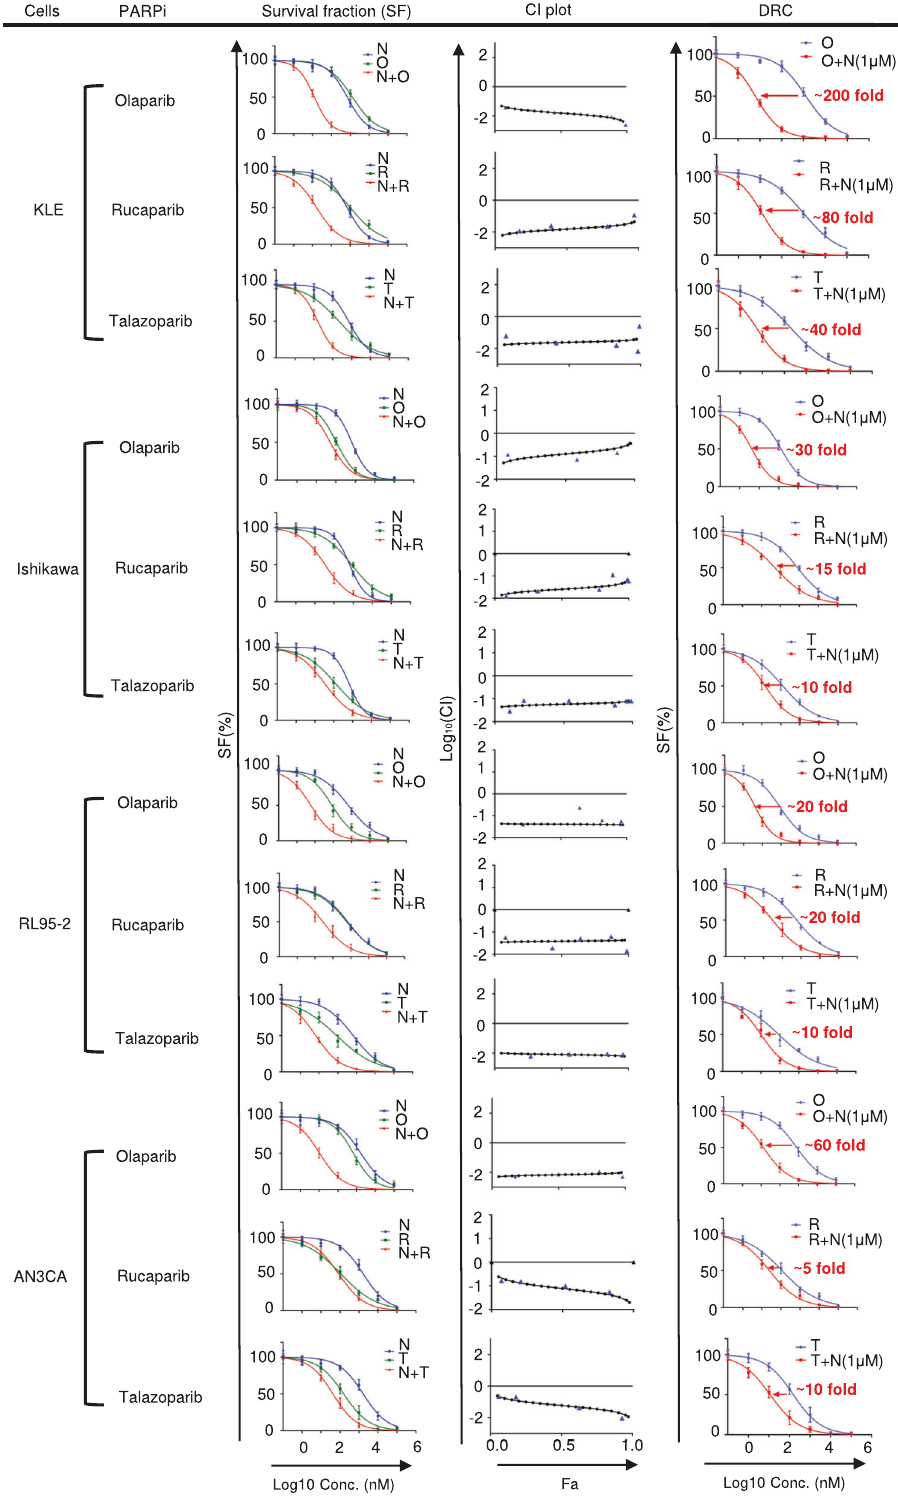
Fig. 1 NPB synergizes with PARPis to decrease EC cell survival. Chou-Talalay synergy analysis for NPB (N) in combination with three PARP inhibitors, namely Olaparib (O), Rucaparib (R) or Talazoparib (T), in a panel of EC cells including KLE ( PTEN- pro fi cient), AN3CA ( PTEN- de fi cient), Ishikawa ( PTEN- de fi cient) and RL95-2 ( PTEN- de fi cient). Cells were treated with the indicated concentration (log 10 scale) of NPB and mentioned PARP inhibitor for 6 days. The survival fraction was assessed using a total cell number assay. The logarithmic combination index (CI) value corresponding to cell fraction affected (Fa) was determined using the CompuSyn software (http://www.combosyn.com) as described in “ Materials and methods ” . CI value indicates: <1 synergism; = 1 additive Synergy; >1 antagonism ( n = 3). Dose-response curves for a panel of cells treated with the indicated concentration of PARP inhibitors with or without 1 µM NPB in total cell number assays. Arrow indicates fold reduction in respective PARP inhibitor IC 50 in the presence of NPB ( n = 3). Cell Death and Disease (2022)